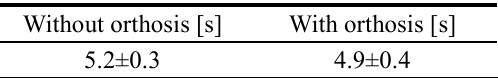
Table 2 Walking cycle in the experiment